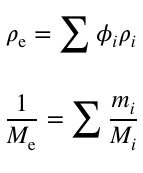
Fig. 12 RI of various components of oil: paraffins, aromatics, and